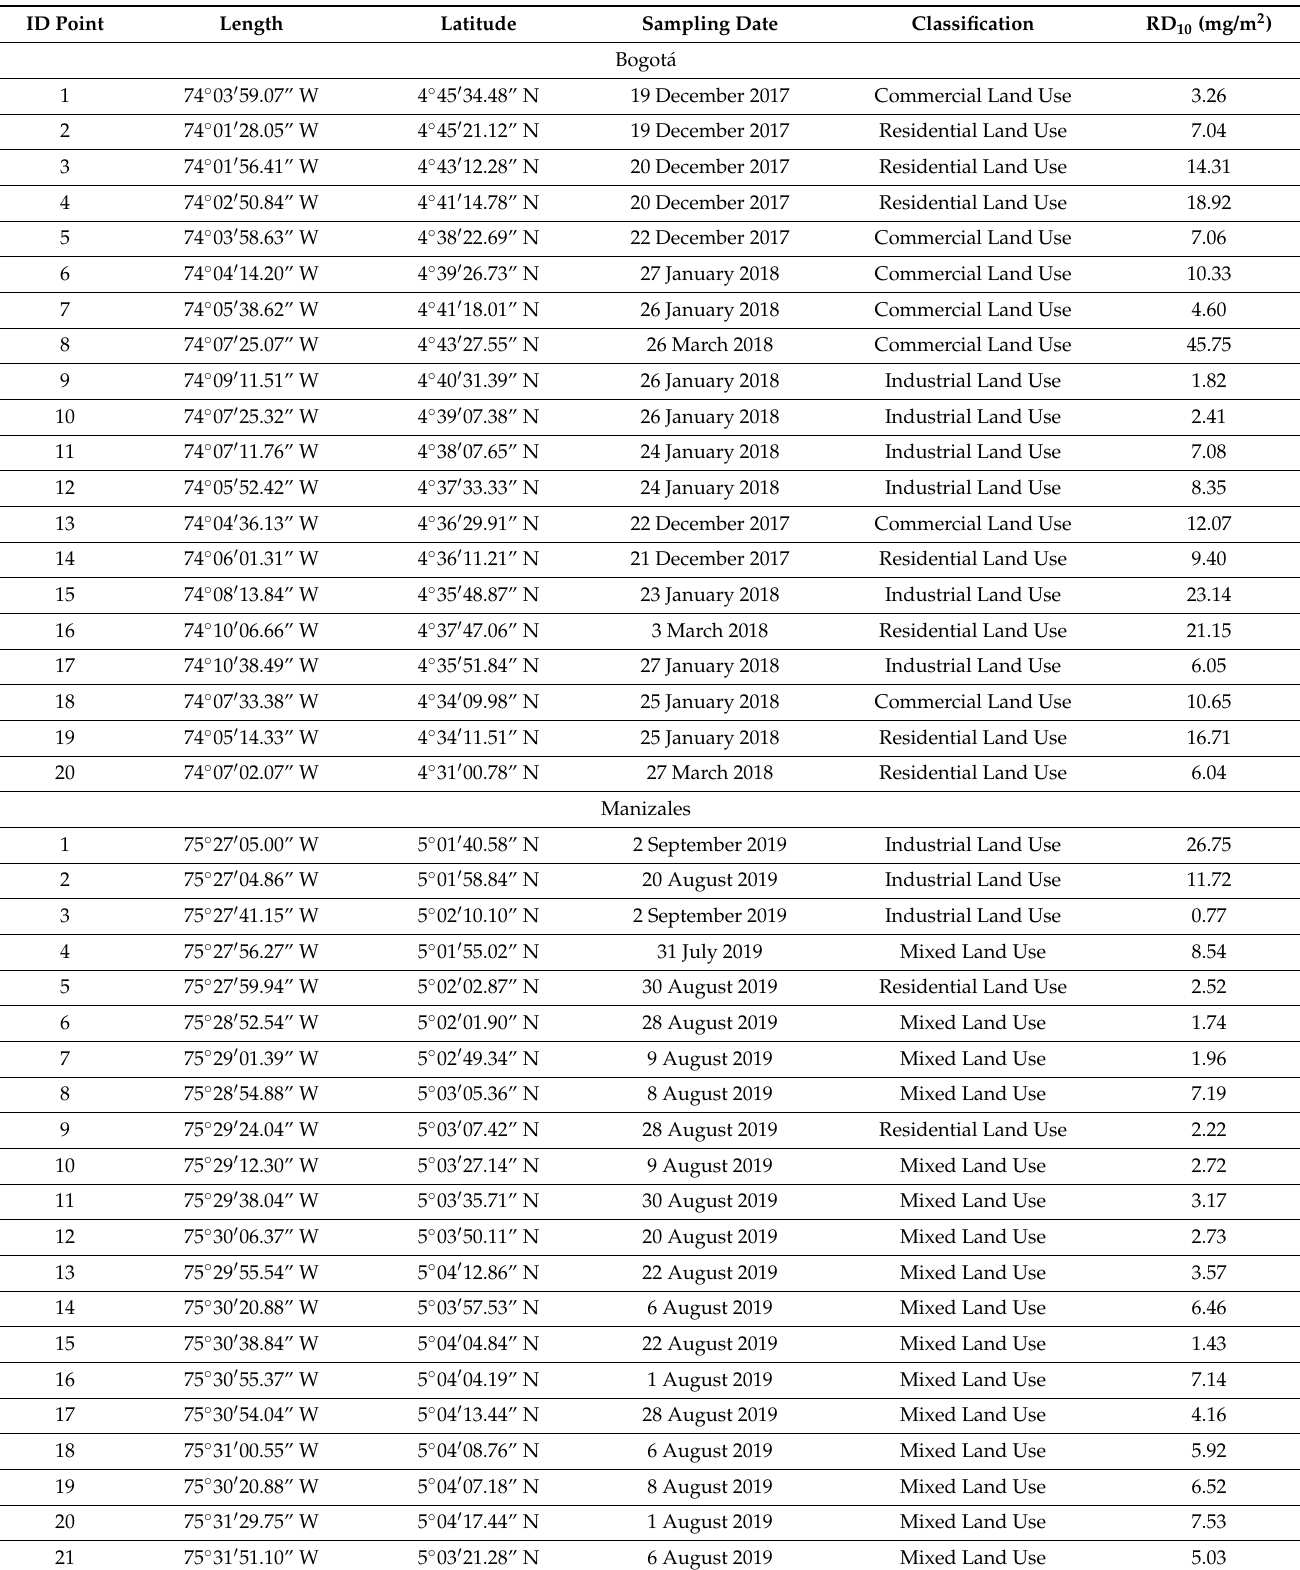
Table 1. Average loading of RD 10 at each